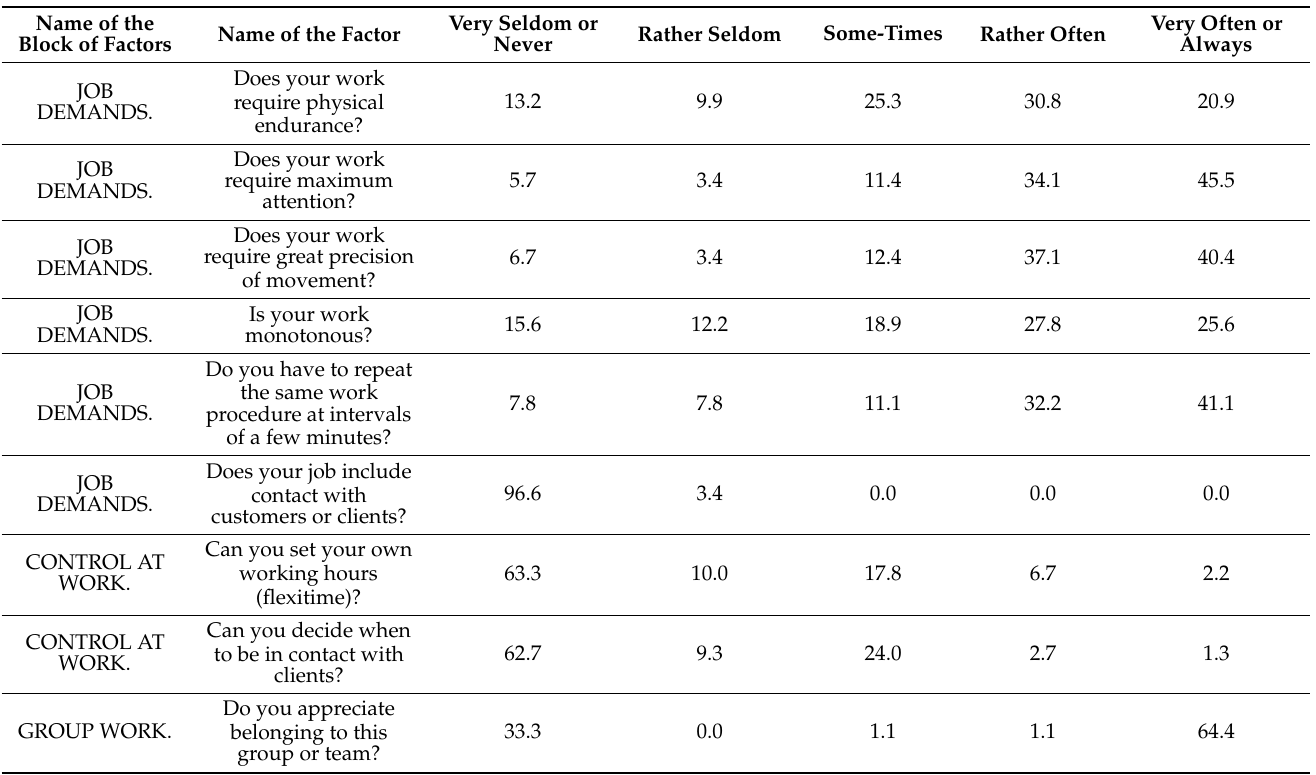
Table 10. General labor factors of loggers with shift work organization in the Far North (% of the total sample).